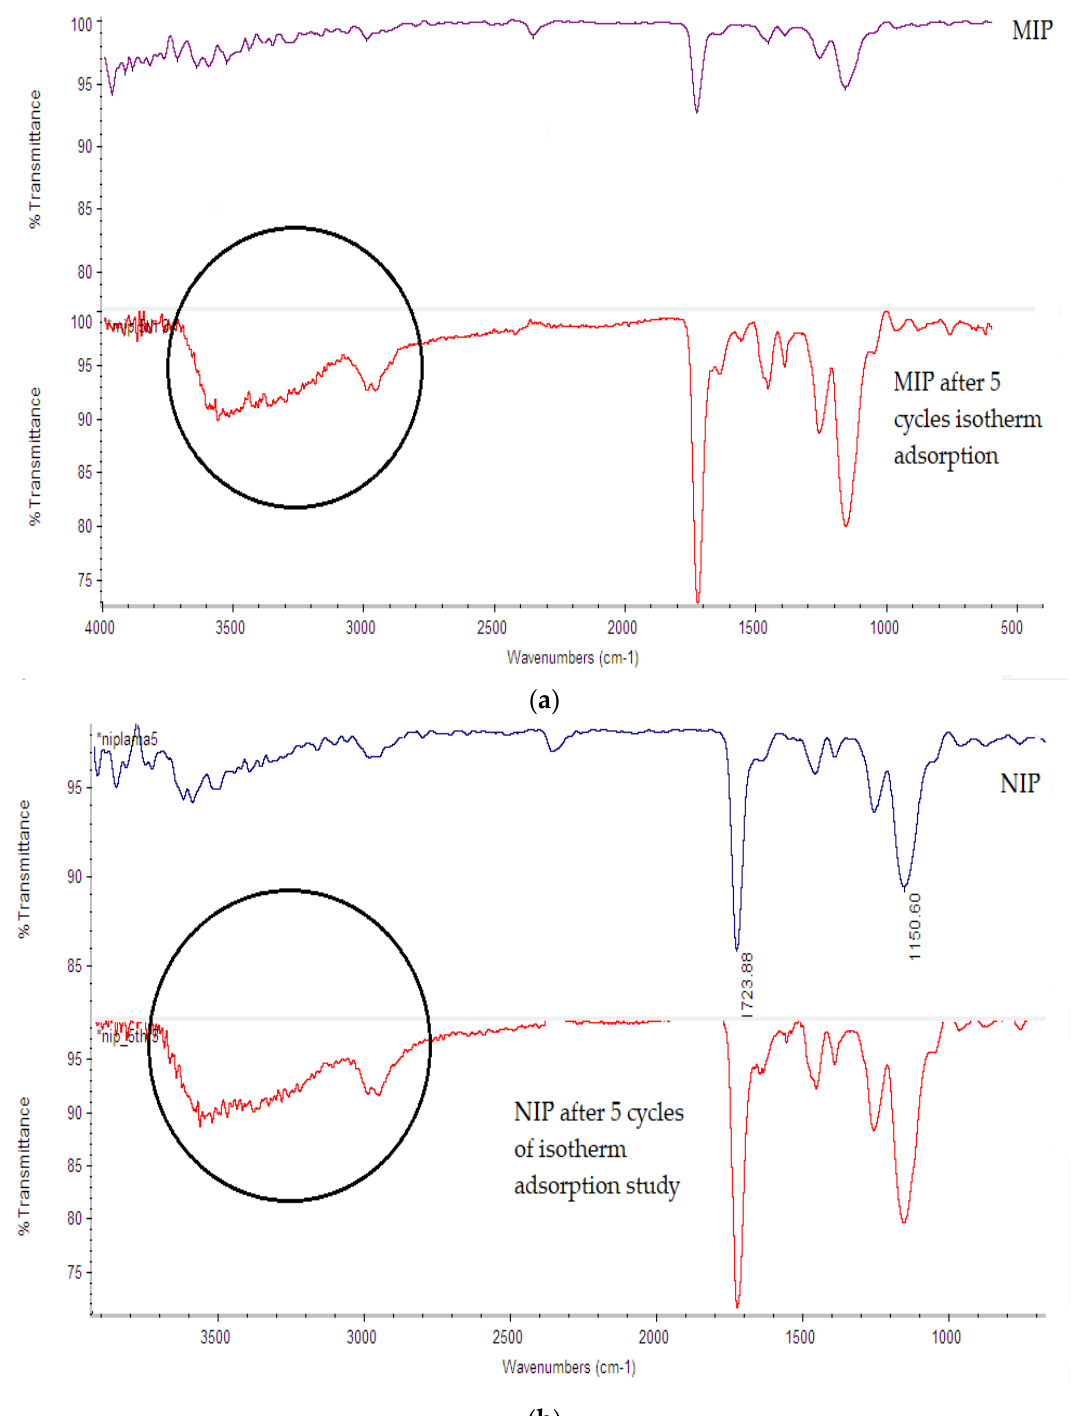
Figure 8. FTIR spectrum of MIP ( a ) and NIP ( b ) before and after undergo five cycles isotherm adsorption study.